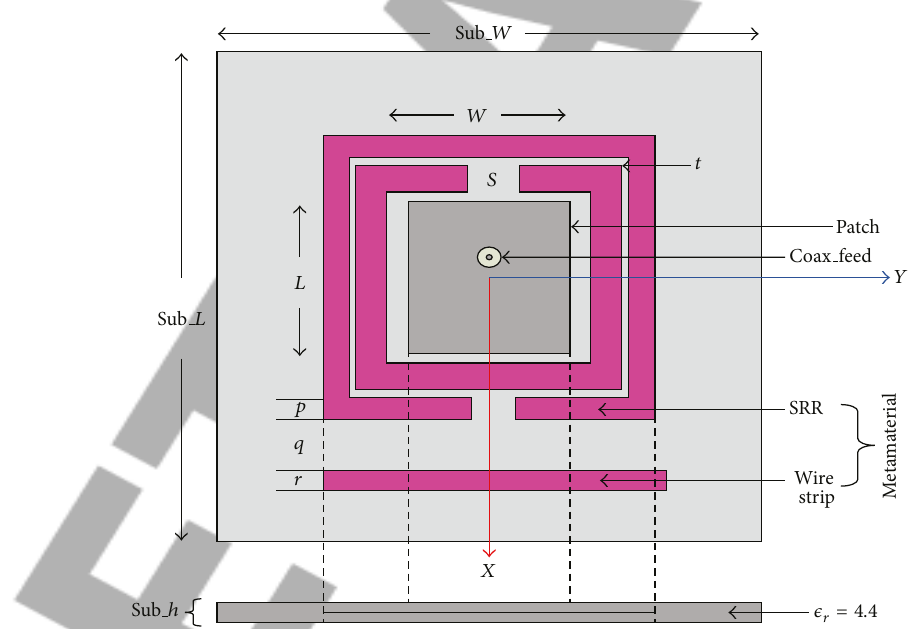
Figure 2: Square SRR based metamaterial inserted antenna layout. Parameters are sub 𝑊 = 90 mm, sub 𝐿 = 100 mm, 𝑊 = 30 mm, 𝐿 = 40 mm, sub ℎ = 3.2 mm, 𝑝 = 5 mm, 𝑞 = 10 mm, 𝑟 = 5 mm, 𝑠 = 5 mm, and 𝑡 = 1 mm.